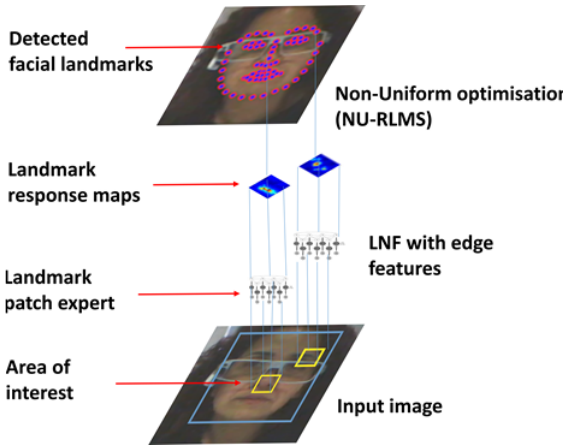
Figure 1 . A demonstration of OpenFace methodology, adapted from Baltrušaitis et al. (2013) It is intentionally lim- ited to two landmarks patch expert for the sake of clarity (all photos used upon the permission of the